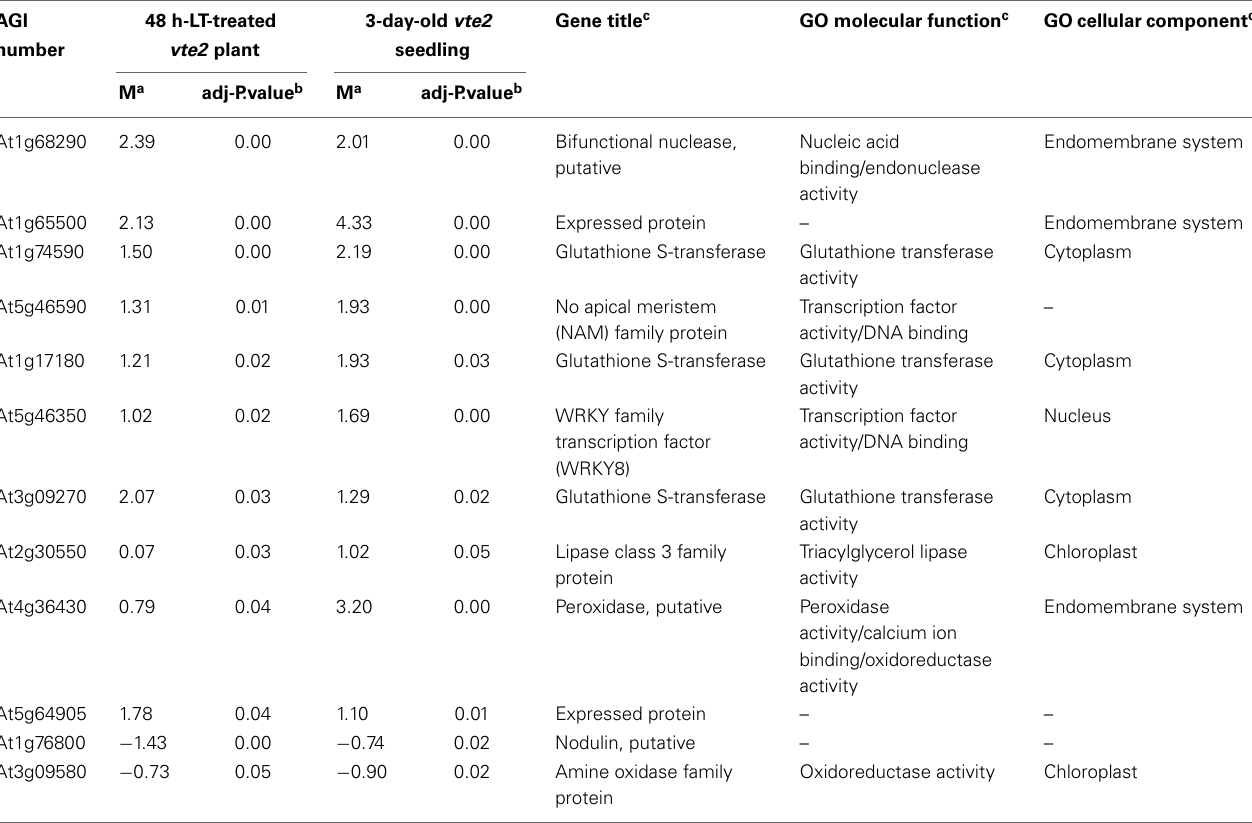
Table 3 | The 12 genes that are common between the 77 significantly different genes in 48 h-LT-treated vte2 plant and 744 significantly different genes in 3-d-old vte2